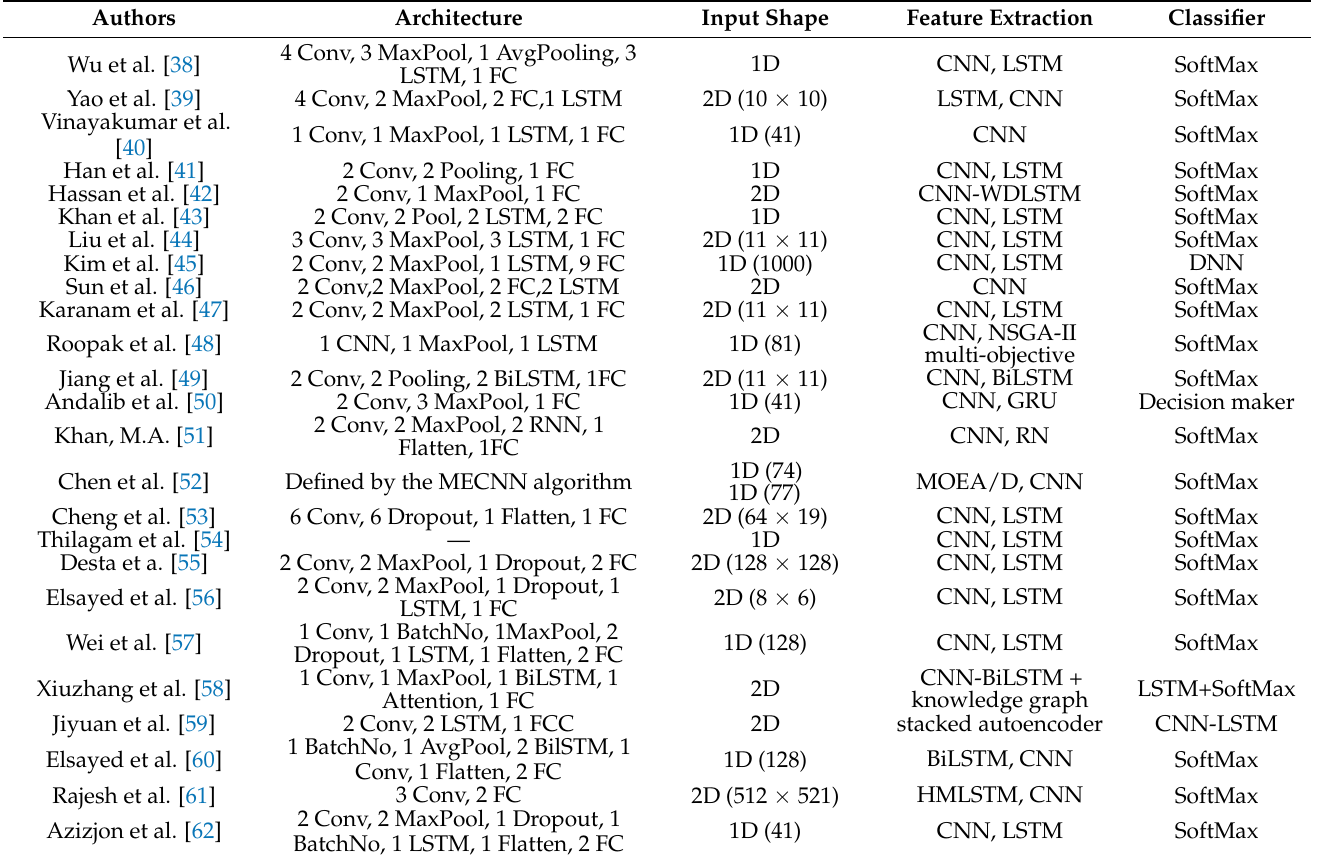
Table 8. Architectural properties of group 2 (Hybrid CNN and RNN) IDS